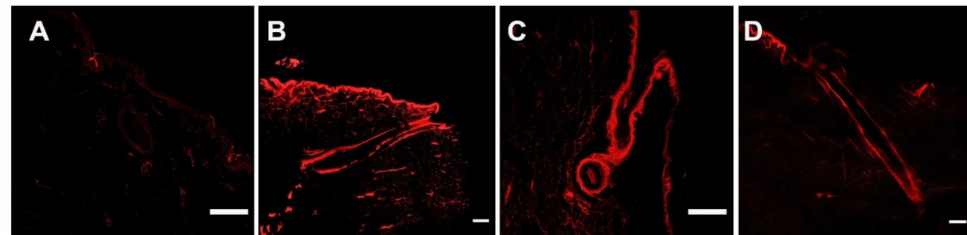
Figure 3. Pig skin hair follicle penetration of R-TH-NPs in 24 h by confocal microscopy. ( A ) untreated (control), ( B ) R-TH-NP-L-, ( C ) R-TH-NP-P- and ( D ) R-TH-NP-P+. Scale bar: 200 µ m.